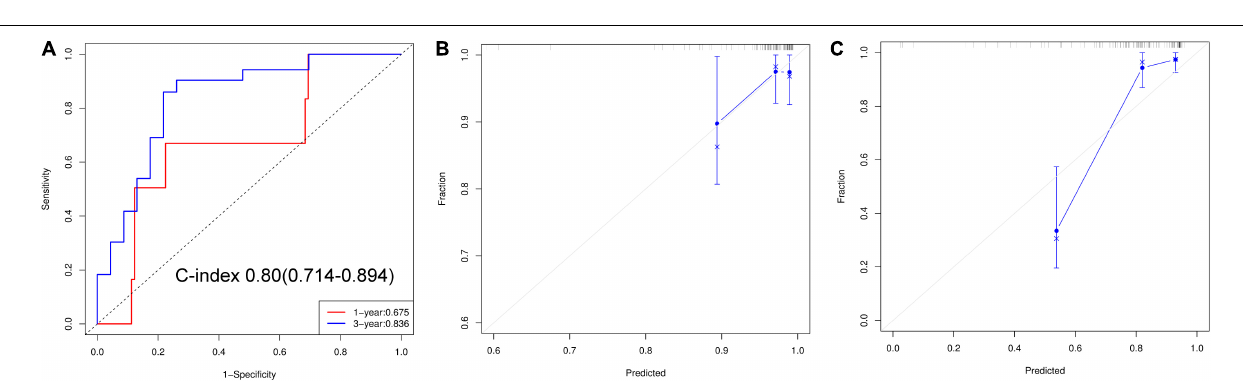
Frontiers in Cardiovascular Medicine |